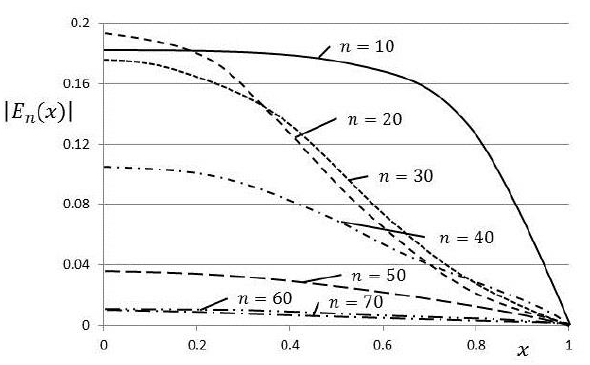
Figure 9. The curves of the absolute error remainder functions.